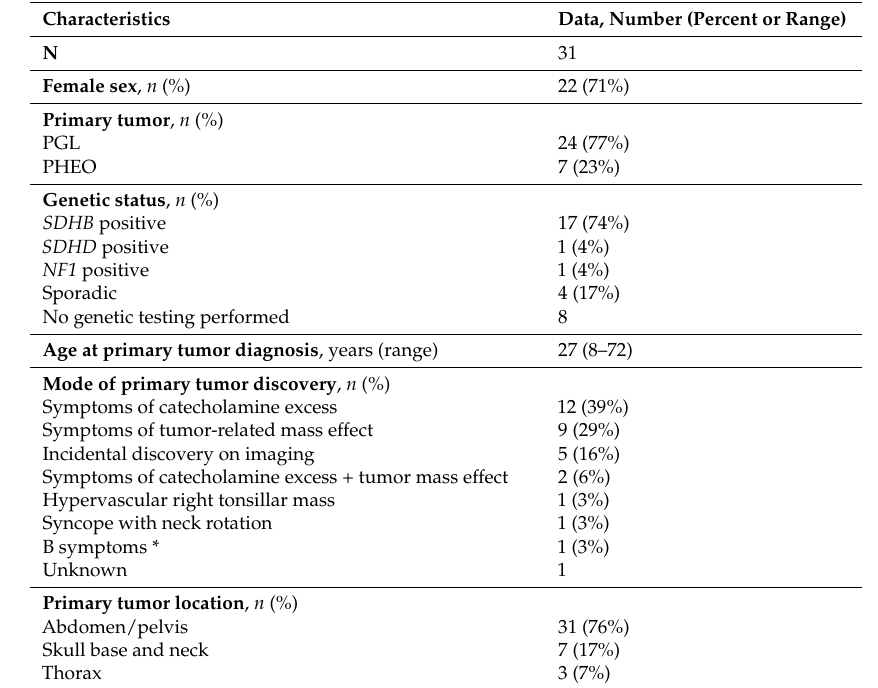
Baseline clinical characteristics of patients with metastatic pheochromocytoma and paraganglioma treated with ablative therapy. Categorical data presented as absolute and relative frequencies (percentages). Continuous data presented as median (minimum–maximum range). * B symptoms include fevers, chills, night sweats, weight loss, and anorexia. Abbreviations: